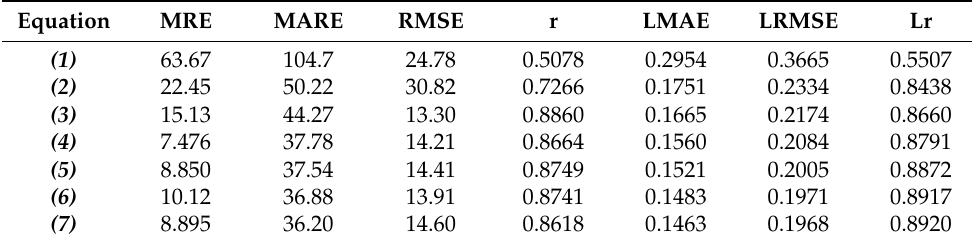
Table 3. The precisions of the different algorithms used to estimate the TSM concentrations in the Pearl River Estuary. MRE represents mean relative error, MARE represents mean absolute relative error, RMSE represents the root mean squared error (g m − 3 ), r represents correlation coefficient, LMAE represents mean absolute error (g m − 3 ) in log-10 space, and LRMSE and Lr represent RMSE and r in log-10 space,